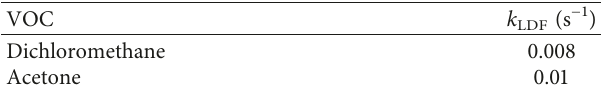
Figure 6: Breakthrough curves for acetone adsorption on activated carbon at (a) 298K, (b) 313K, (c) 323K. Symbols: experimental data. Lines: LDF model. Table 2: Mass transfer coefficients k LDF for VOCs vapors for dichloromethane and